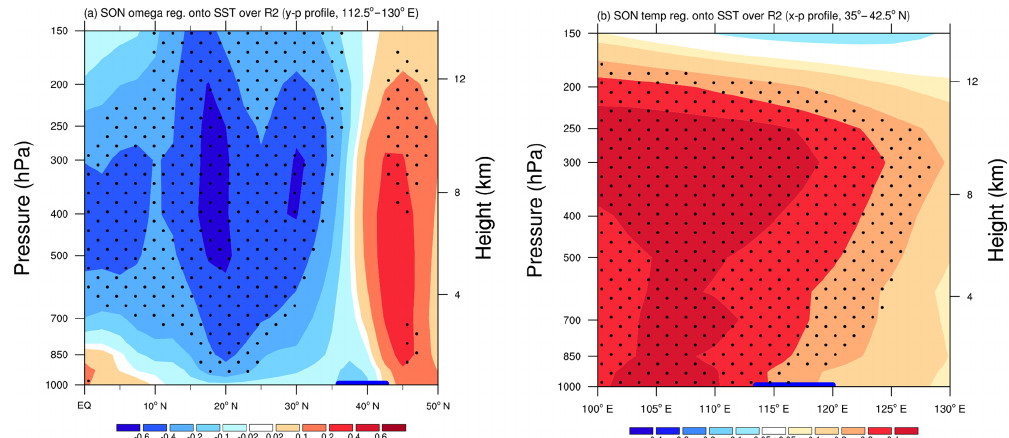
Figure 10. (a) Latitude–height cross section (112.5–130 ◦ E) of the autumnal omega (shaded; 10 − 2 Pas − 1 ) and (b) longitude–height section (35–42.5 ◦ N) of the autumnal air temperature (shaded; ◦ C) anomalies regressed onto the simultaneous interannual component of the SST over R2. Regression coefficients that are significant at the 90% confidence level are stippled. The thick blue horizontal bars superimposed onto the abscissa of panels (a) and (b) indicate the latitudes and longitudes of the BTH region, respectively.